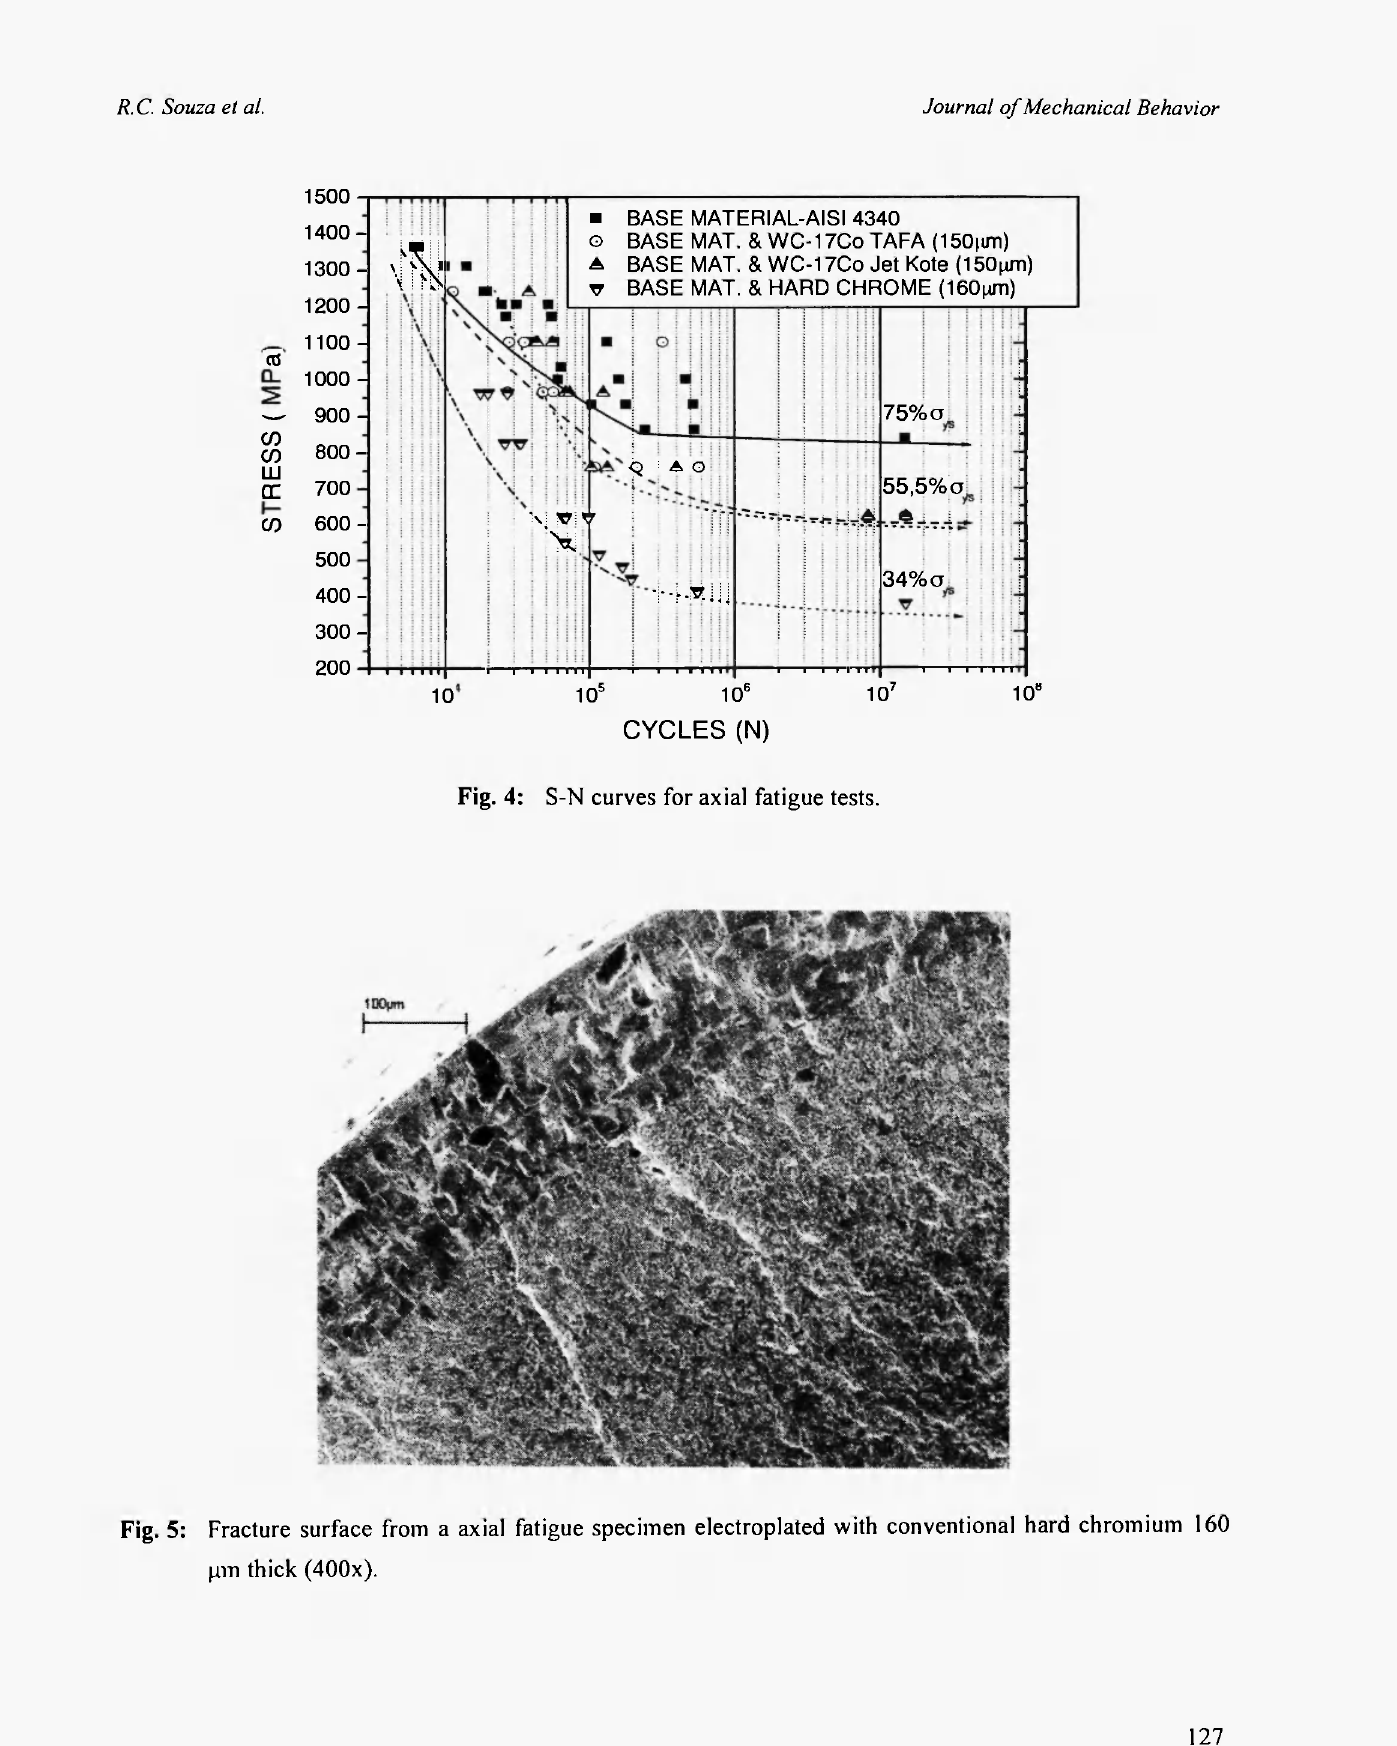
Fig. 5: Fracture surface from a axial fatigue specimen electroplated with conventional hard chromium 160 μιτι thick